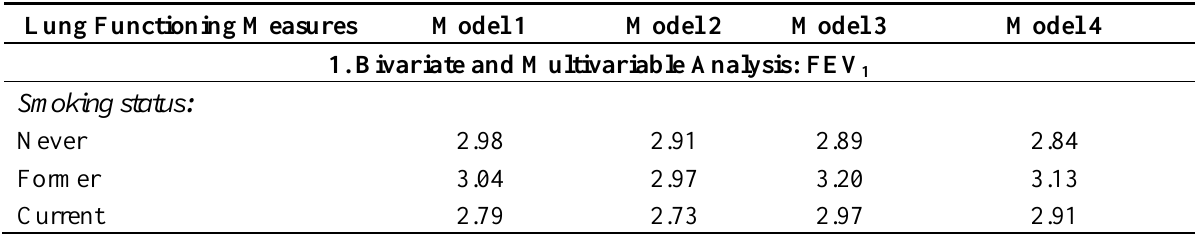
Table 4. Multivariable and Odds ratio Analysis of mediation of sedentary lifestyle on the association of smoking status and lung function among African American